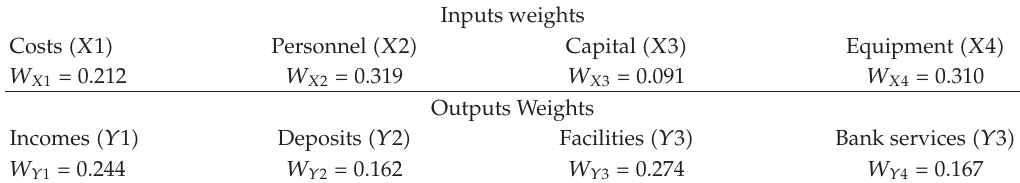
Table 6: The final weights of factors based on confined fuzzy weights. Inputs